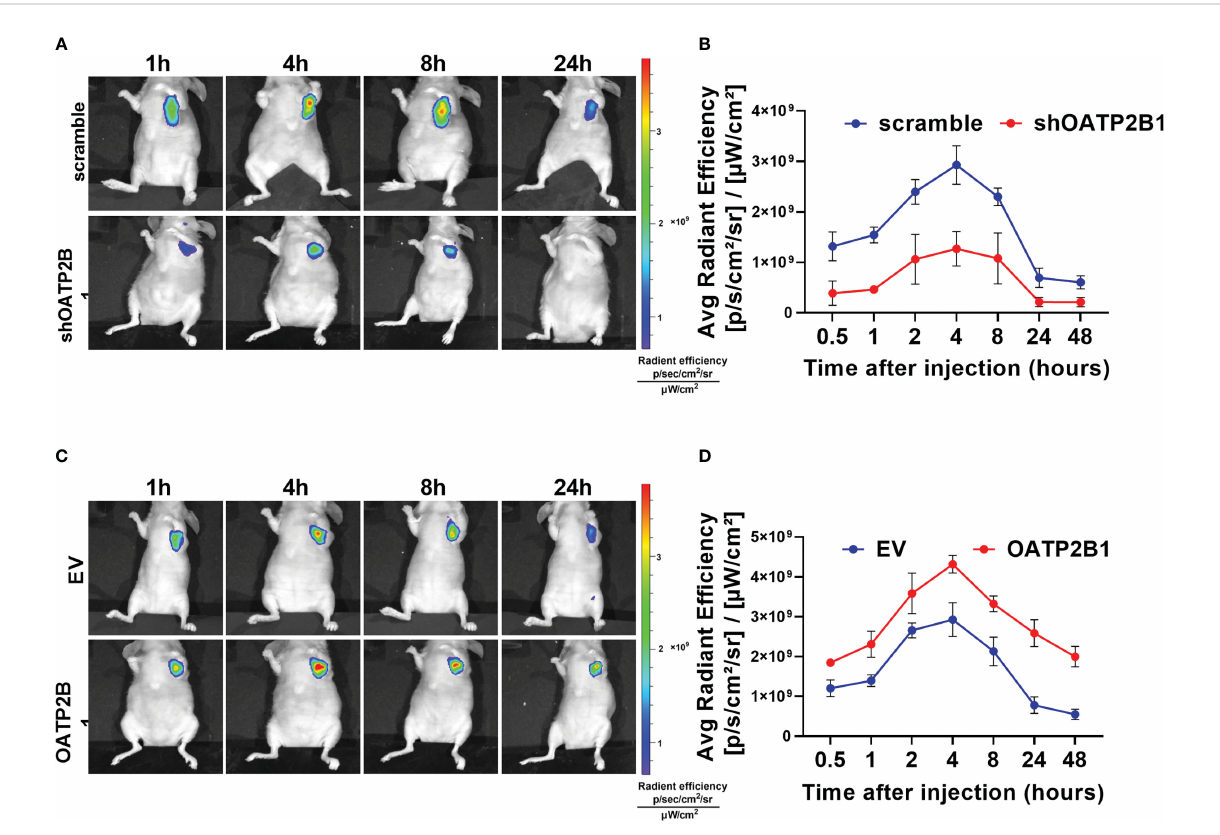
FIGURE 3 OATP2B1 is involved in uptake of MHI-148 in tumor xenografts. (A) Time-dependent intensity images of nude mice bearing subcutaneous tumors xenografts of SNU-739 cells with OATP2B1-knockdown (shOATP2B1) after receiving an intravenous injection of MHI-148 (0.75 m mol kg -1 ). (B) Quanti fi cation of MHI-148 fl uorescence intensity in (A) . (C) Time-dependent intensity images of nude mice bearing subcutaneous tumors xenografts of SNU-739 cells with overexpressed OATP2B1 (OATP2B1) after receiving an intravenous injection of MHI-148 (0.75 m mol kg -1 ). (D) Quanti fi cation of MHI-148 fl uorescence intensity in (C) . Data shown are the mean ± SD from three independent experiments, where